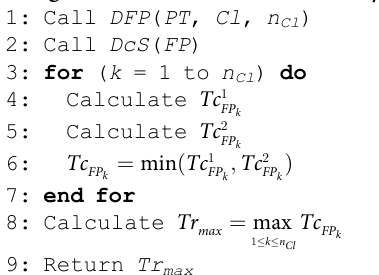
Algorithm 4 Critical confidentiality level algorithm ( CCL )